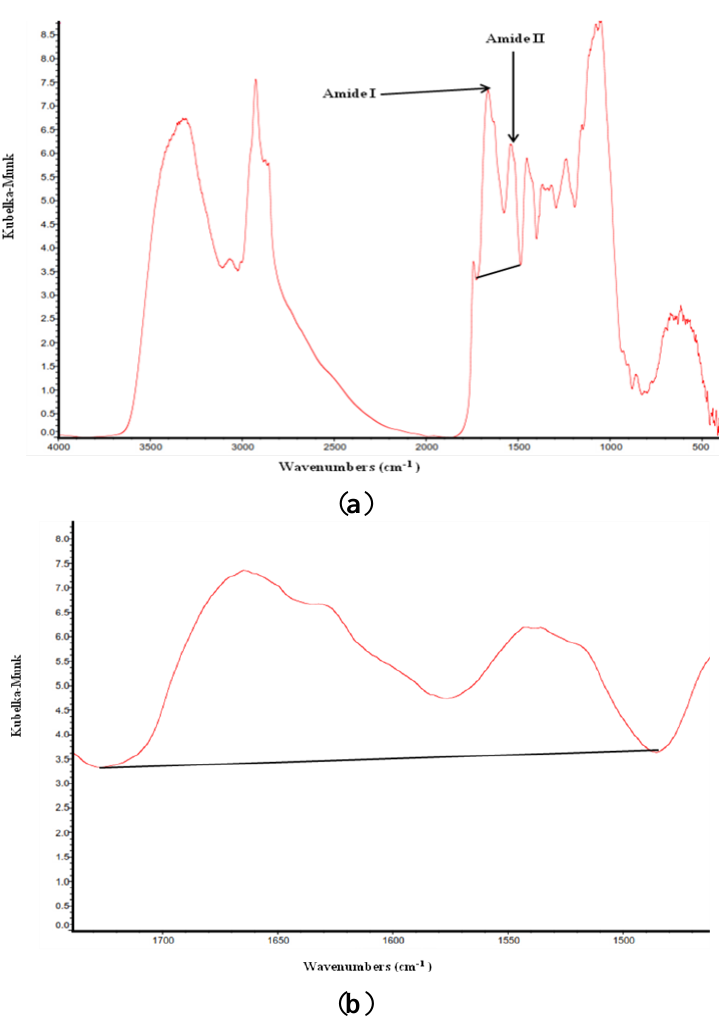
(at ca . 1719–1485 cm −1 ) and ( b ) enlargement of amide I and II